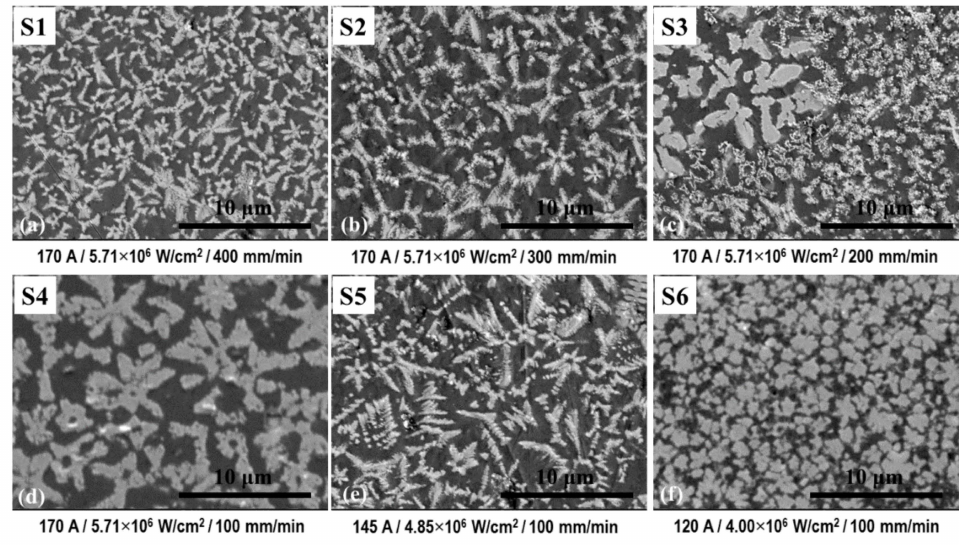
Figure 5. SEM micrographs of the laser-processed coatings S1–S6: the microstructure prevailing in the top layer of the coating; lighter inclusions—W-rich phases, darker matrix— γ Ni-based phase. The chemical microanalysis by EDS (point—in Table 2; maps—in Figure 6) showed that W-rich precipitates contain a significant amount of C, Cr, and Ni and a particular con- centration of Fe. Besides prevailing microstructure, shown in Figure 5, regions containing W-rich precipitates of different sizes and shapes were observed in the top layer for all the samples as well. Figure 6 shows typical examples. EDS revealed that the W-rich precipitates of different sizes and shapes do not differ visibly in their composition (Table 2, Sp.1–Sp.6). According to the atomic C ratio to metals, the W-rich phase can be identified as a complex carbide of MeC type, where Me corresponds to W + Cr + Ni + Fe. EDS analysis of Ni-based matrix showed that in coating areas, where fine dendritic tungsten carbides are formed (typically, applying 170 A laser current), the concentration of Co is slightly larger as compared with that of coatings areas with coarser tungsten carbides, possibly remaining due to noncomplete dissolution of primary WC- based particles (Table 2, Sp.7–Sp.12). Such increase, most likely, can be attributed to a more complete dissolution of WC particles and the mixing of binder components with Ni-based matrix at higher laser power. For S3 and S4 series, the increase in Fe concentration in matrix was observed as well, related to substrate melting and admixing. Table 2. Chemical composition of W-rich phases and Ni-based matrix in points showed in Figure 6 (by EDS). W-Rich Phase (in Element